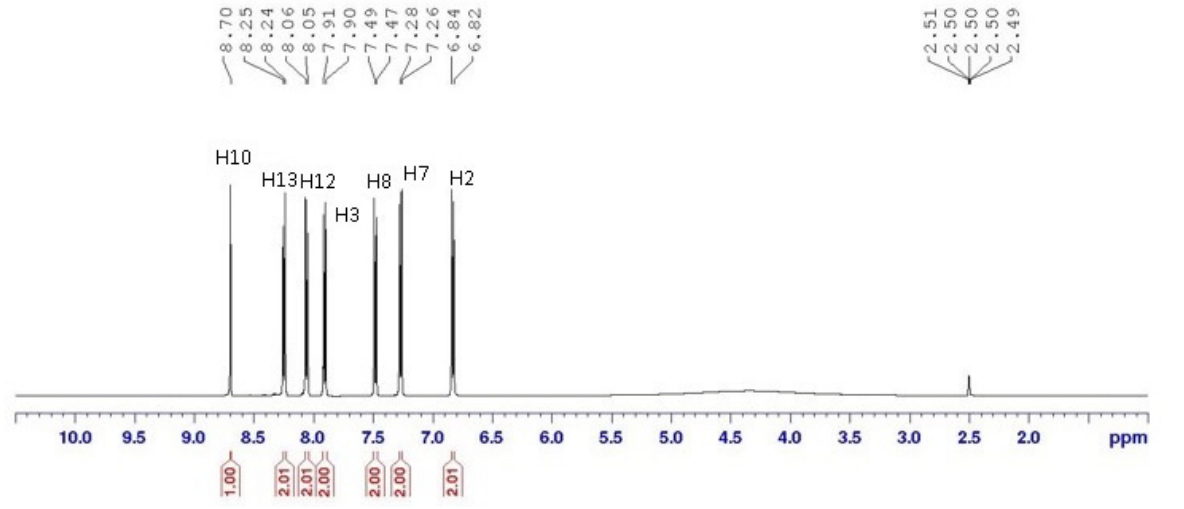
Figure 3. 1 H NMR (500 MHz, DMSO-d 6 ) of compound 4a.